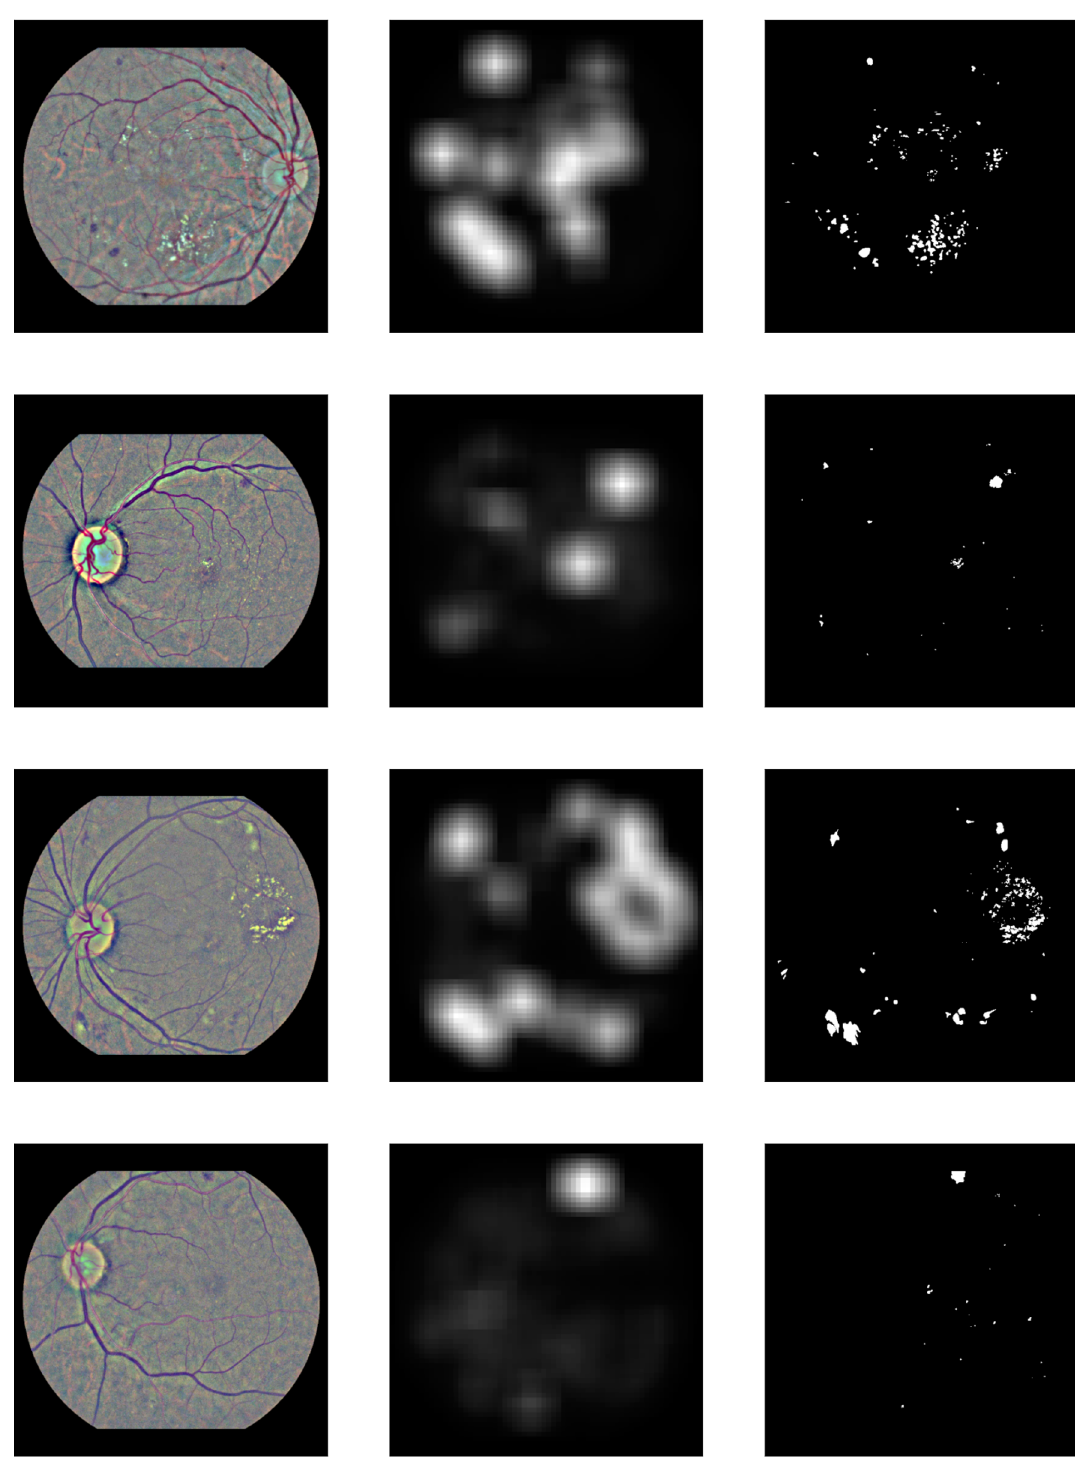
Figure 7. Examples of the attention heatmaps (middle column) produced by the model for 4 IDRiD images (left column), presented side-by-side with the available pixel-level lesion ground-truth (right column). For the purposes of easier presentation, the ground-truth images (right column) are a combination of all the available lesion annotations (microaneurysms, haemorrhages and